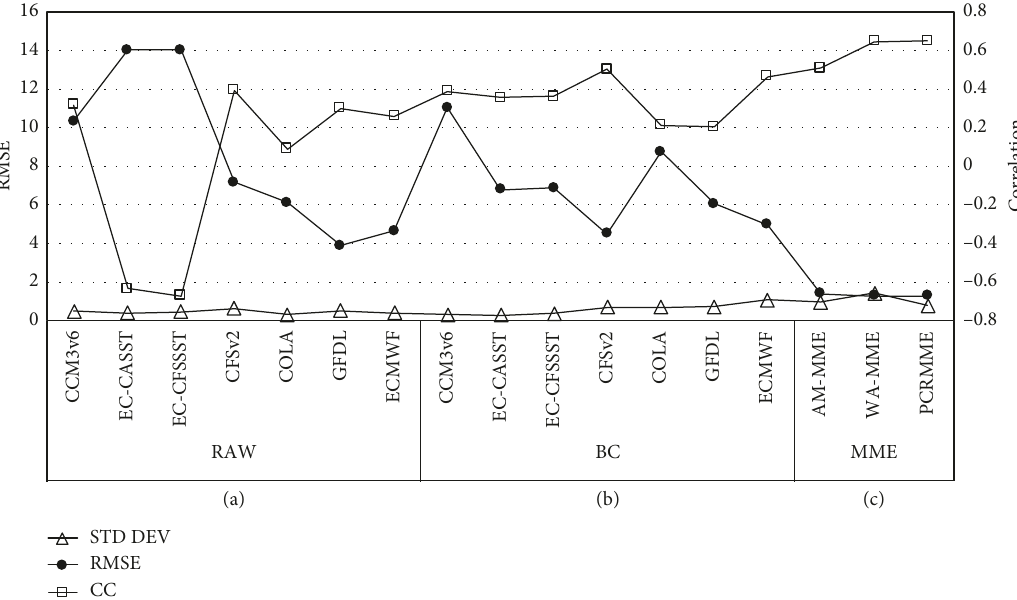
Figure 5: JJAS performance comparison of the raw models with the bias-corrected (BC) models for the overall Myanmar. (a) Raw models. (b) Bias-corrected models. (c) MMEs. Table 2: Correlation coefficients, root mean square error, and standard deviation for the JJAS season for the six identified zones. Methods/zones